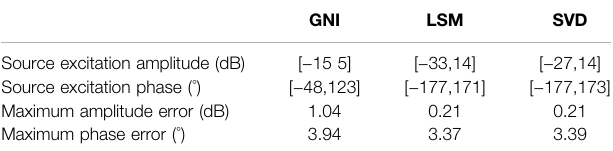
TABLE 2 | Comparison of simulation of different algorithms in 3.3 GHz. GNI LSM SVD Source excitation amplitude (dB)